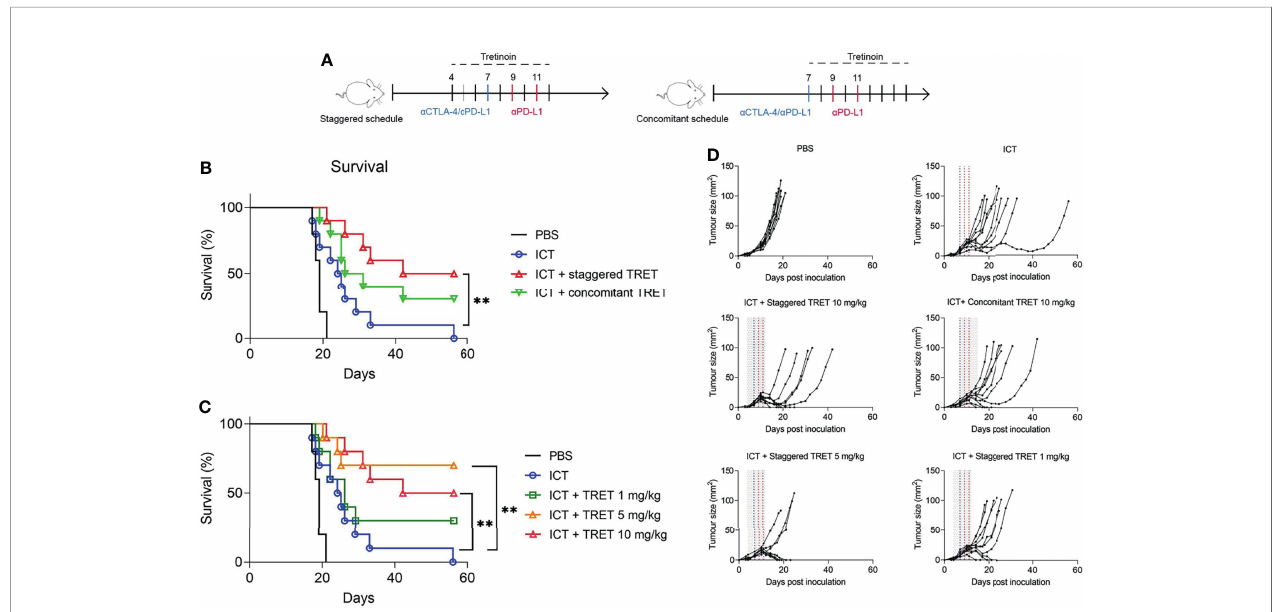
FIGURE 2 | Tretinoin enhances ICT ef fi cacy in a schedule and dose-dependent manner. (A) Experimental design. AB1-HA bearing mice were treated with a CTLA-4 on day 7 and a PD-L1 on day 7, 9 and 11. Tretinoin treatment commenced three days prior to (staggered tretinoin, tumour size ~4 mm 2 ) or on the same day as ICT (concomitant tretinoin, tumour size ~10 mm 2 ) and administered at 10 mg/kg for 9 consecutive days. (B) Survival of mice treated with ICT and either staggered or concomitant tretinoin. (C) Survival of mice treated with 10 mg/kg, 5 mg/kg or 1 mg/kg tretinoin using the staggered schedule. (D) Individual tumour growth of mice treated with tretinoin (grey lines), a CTLA-4 (blue line) and a PD-L1 (red lines). The Log-rank test was used for survival analysis